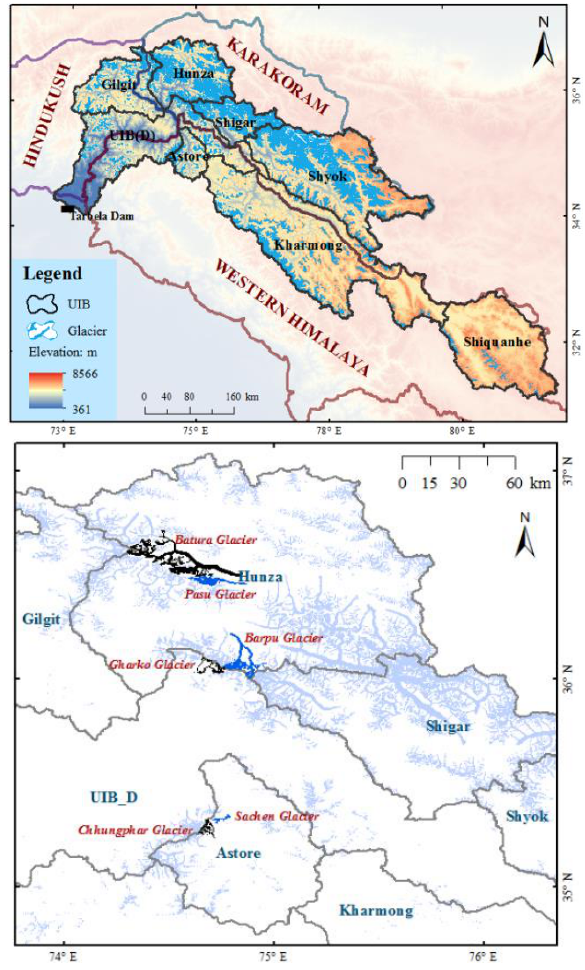
Figure 1. The study region and subregions and sources of the glacier inventory, in the northwestern TP. The distribution of glaciers in the UIB area in the HKH ranges and the location of the six observed glaciers in the UIB region, where the SRTM-X DEM voids are filled with erroneous